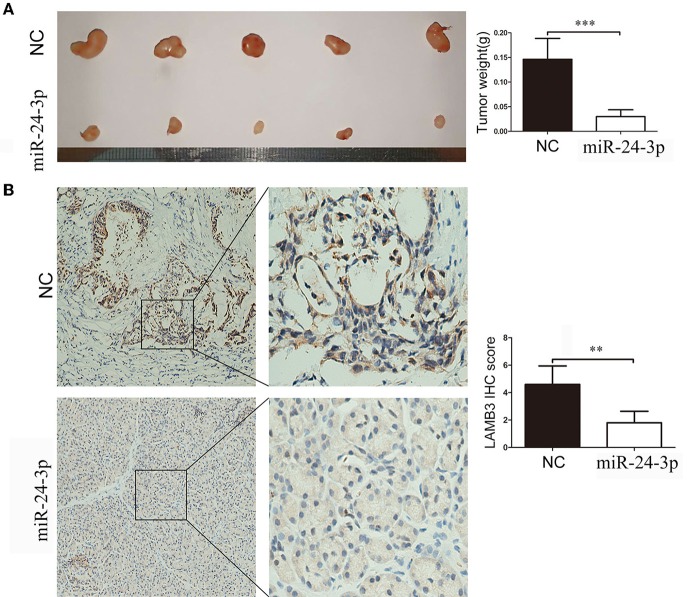
MiR-24-3p inhibits pancreatic cancer proliferation in vivo. (A) In total, 2 × 106 AsPC-1 cells were implanted subcutaneously in nude mice, and the tumor weight was evaluated after 20 days. (B) IHC results showed that miR-24-3p mimics inhibited LAMB3 expression. Data are presented as mean ± SD of three independent experiments; **p < 0.01, ***p < 0.001, paired t-test.